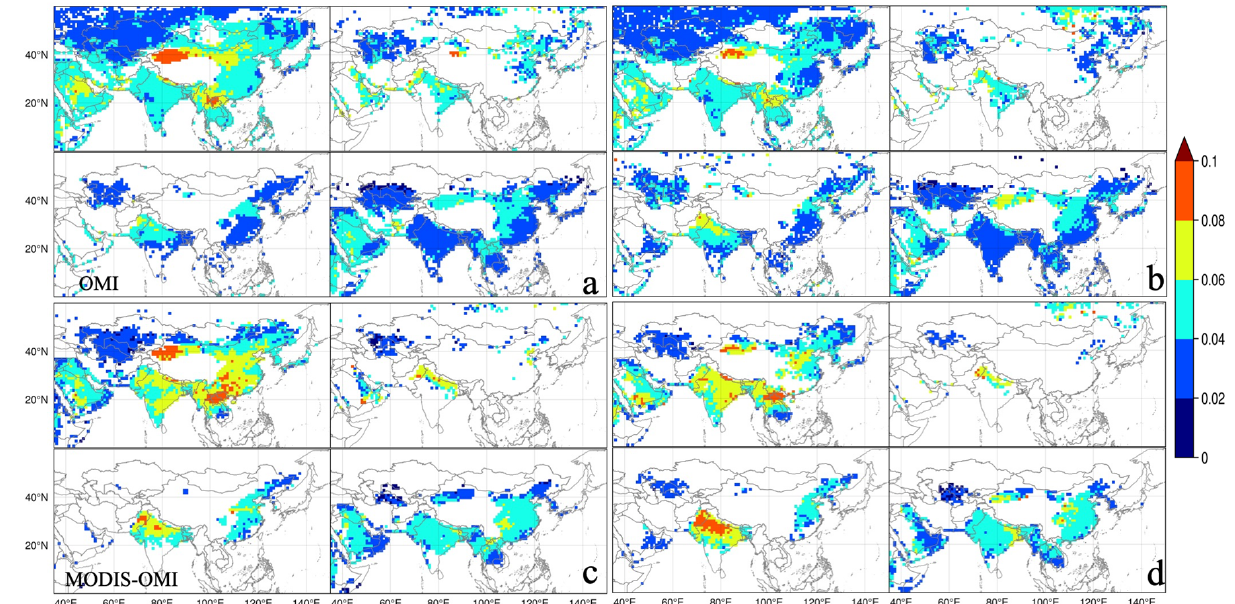
Figure 2. The seasonal smoke AAOD means at 500 nm from OMI and MODIS-OMI for two periods from 2006 to 2022: ( a ) OMI AAOD from 2006 to 2013; ( b ) OMI AAOD from 2014 to 2021; ( c ) MODIS- OMI AAOD from 2006 to 2013; ( d ) MODIS-OMI AAOD from 2014 to 2021.